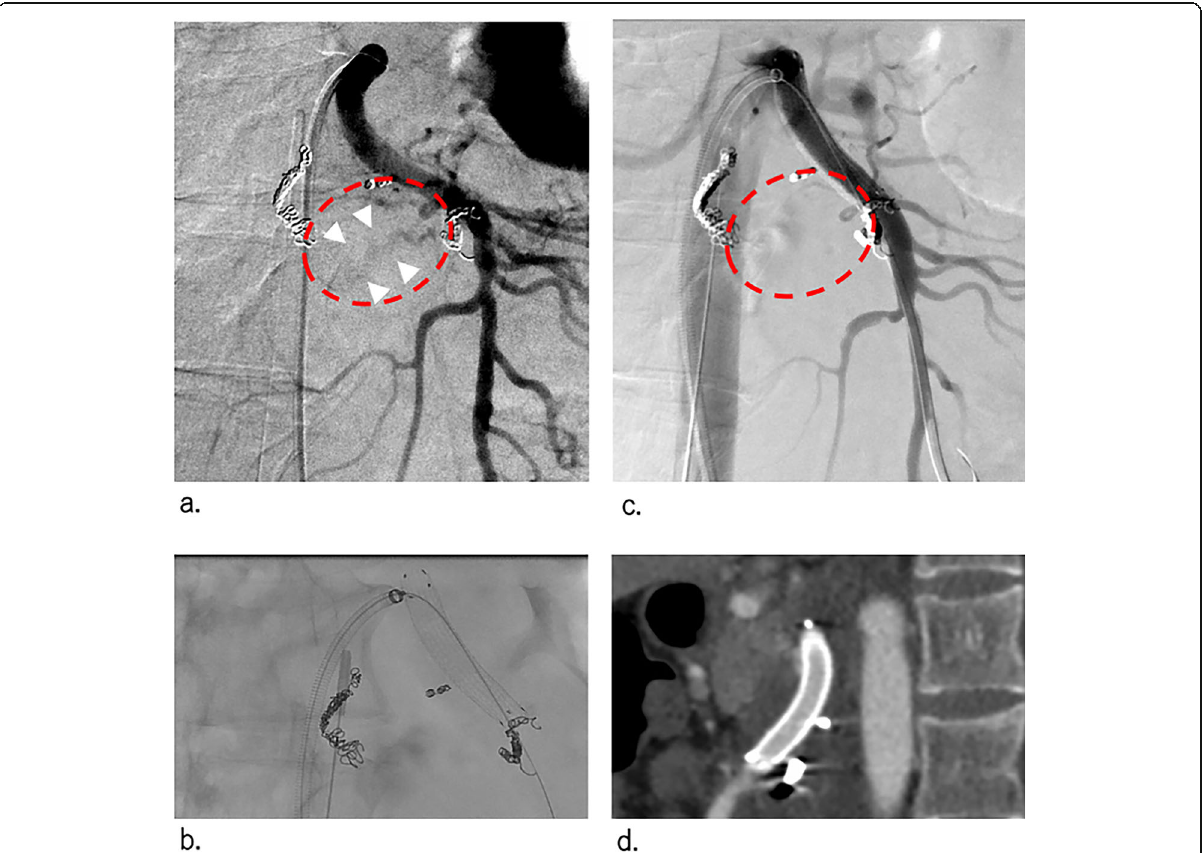
Fig. 4 SMA angiography at stent-graft placement and postoperative computed tomography (CT) ( a ) SMA angiogram, obtained after TAE, showing continued extravasation (white arrowhead in the red circle) without a definite causal artery. b Digital angiogram obtained after stent- graft placement in the SMA trunk (Viabahn, 7 mm × 5 cm). c SMA angiogram, obtained after stent-graft placement, showing the complete disappearance of extravasation (red circle). d Contrast-enhanced CT image, obtained at day 28 after treatment, confirming good patency of the stent